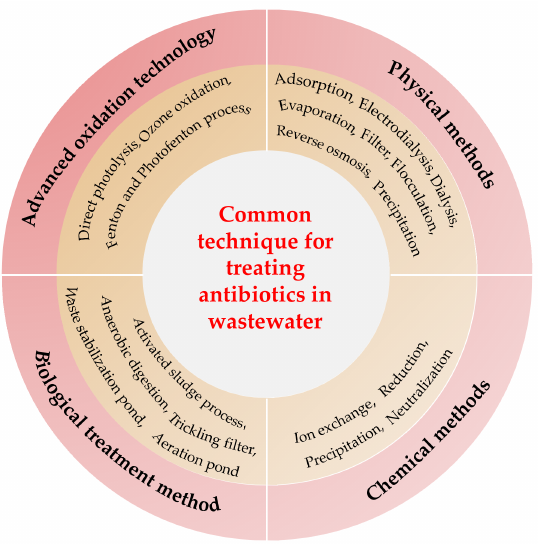
Figure 1. Techniques commonly used to treat antibiotics in